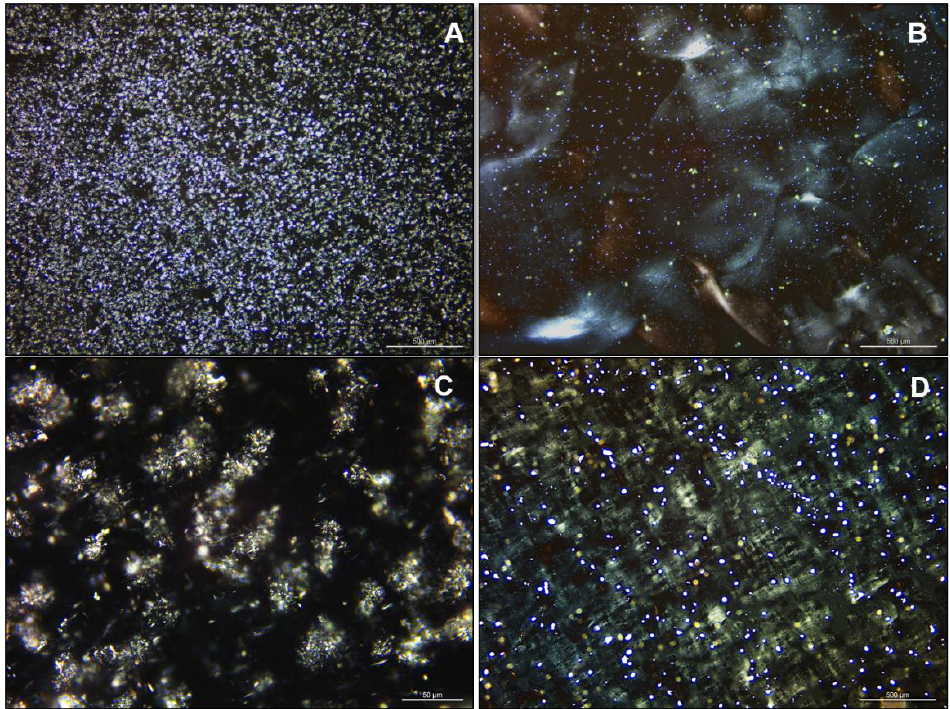
Figure 1. Polarized photomicroscopy images of organogels: ( A ) candelilla wax 2 (CW2):vegetable oil 97 (VO97):vitamin E 1 (VE1); ( B ) 12-hydroxystearic acid 2 (12HSA2):VO96:VE2; ( C ) CW2:VO98; and ( D ) 12HSA2:VO78:VE20. The scale bars are 500 µm in ( A , B , D ), and the scale bar is 50 µm in ( C ).